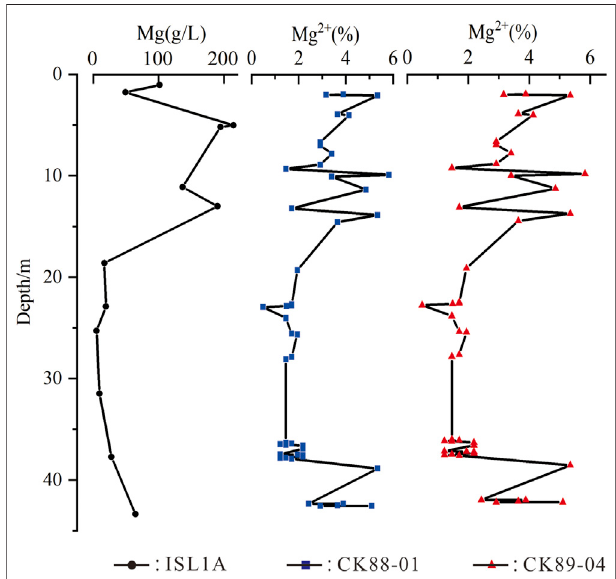
FIGURE 8 | Comparison of the Mg 2+ concentration variation trend of halite fl uid inclusions in boreholes ISL1A, CK88-01, and CK89-04 (the Mg 2+ data in CK88-01 and CK89-04 from Zhang et al. (1993)).